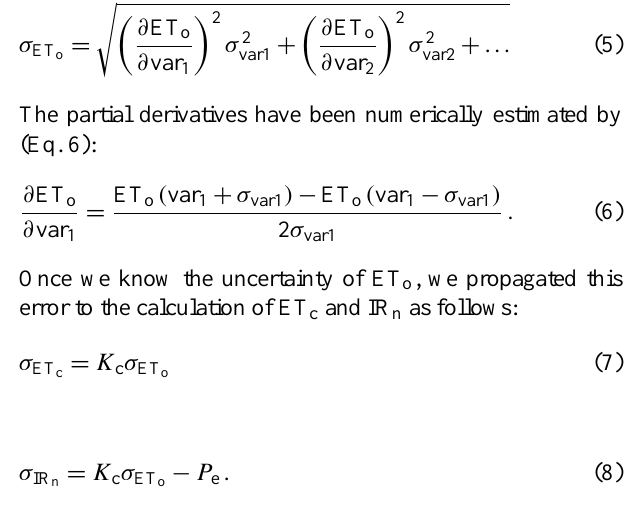
Ejea de los Caballeros Tamarite de Litera